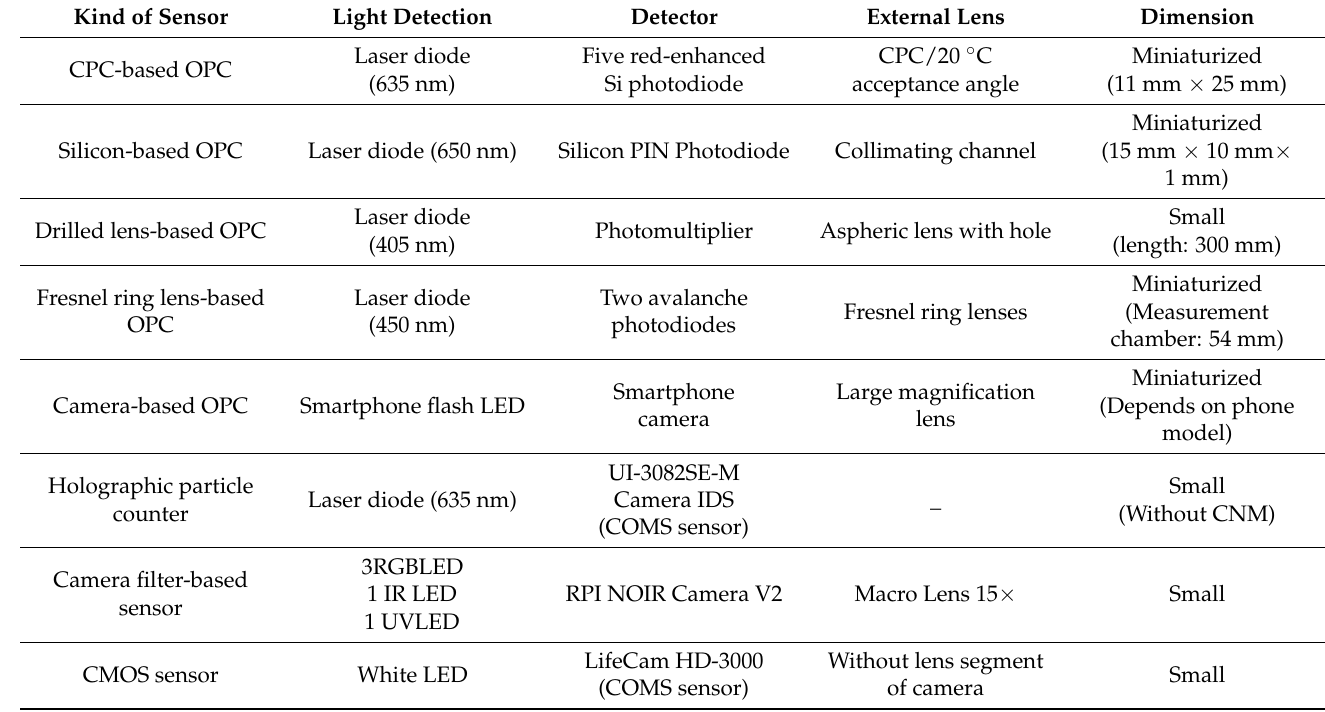
Table 6. Comparison of the components of the novel